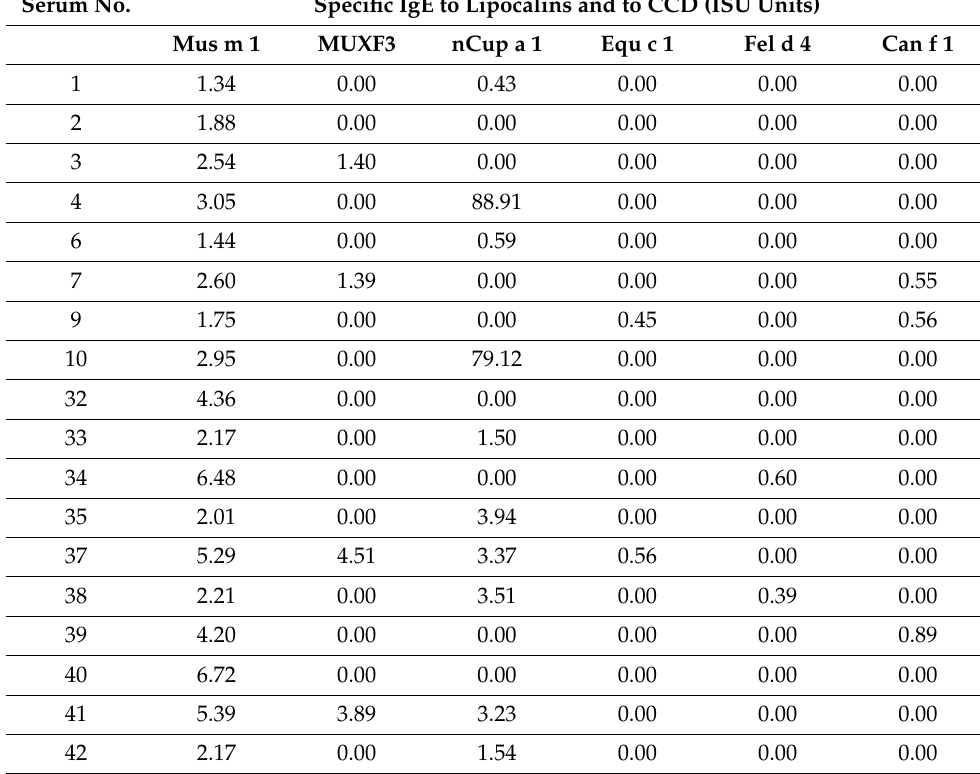
Table 1. Subject characterization by ImmunoCAP ISAC test.